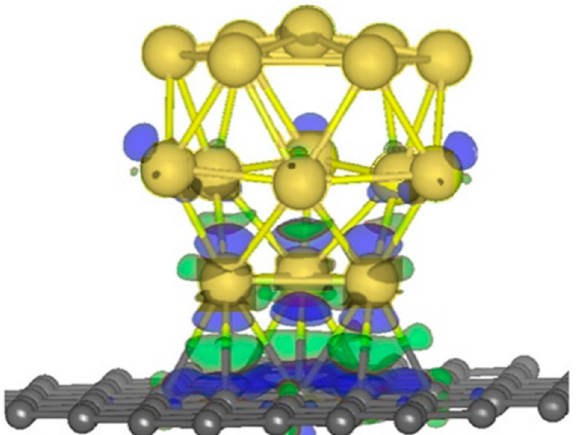
Figure 7. The adsorption of Au 16 on graphene with 5% of tensile strain. The iso-surface of charge redistribution is imposed. Color scheme: C in grey, Au in yellow, Charge depletion (accumulation) in blue (green).